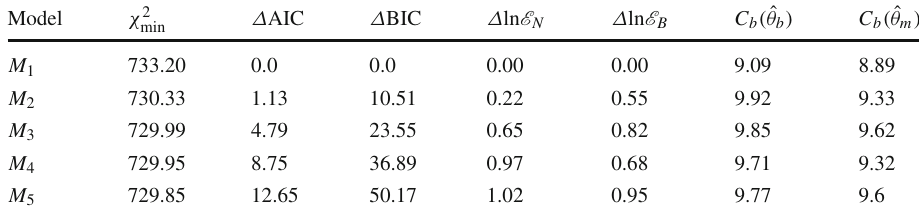
Table 5 The goodness-of-fit statistics χ 2 , Δ AIC, Δ BIC, min Δ ln E for the narrow and broad ranges of priors ( N ( B ) stands for narrow(broad) prior ranges) and the Bayesian complexity for our models